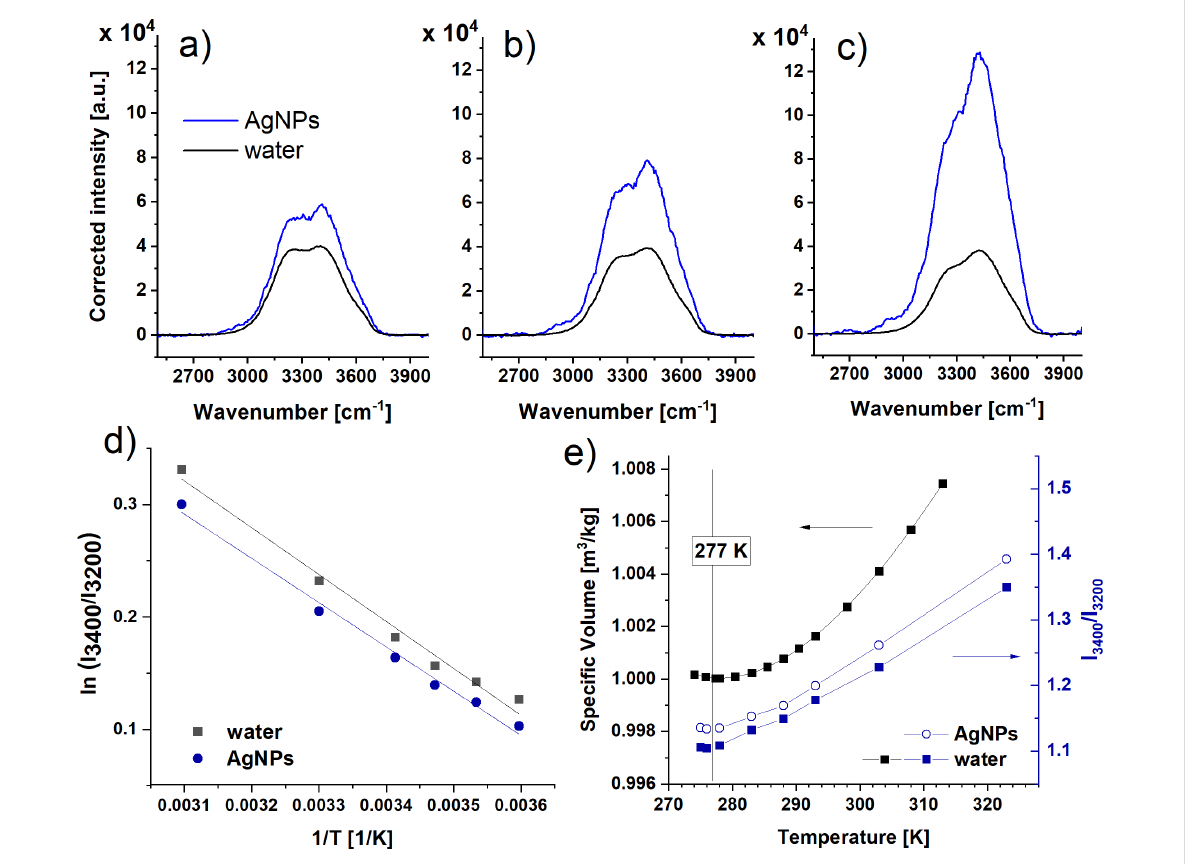
Figure 4: Non-polarized Raman spectrum of water and reabsorption corrected spectrum of AgNPs blue sample at (a) 276 K, (b) 293 K, and (c) 323 K. (d) Arrhenius plot of the ratio Ri = I 3400 / I 3200 for water and AgNPs blue. (e) Dependence of a specific volume with temperature for water and a com- parison of ratios Ri = I 3400 / I 3200 for water and the AgNPs blue